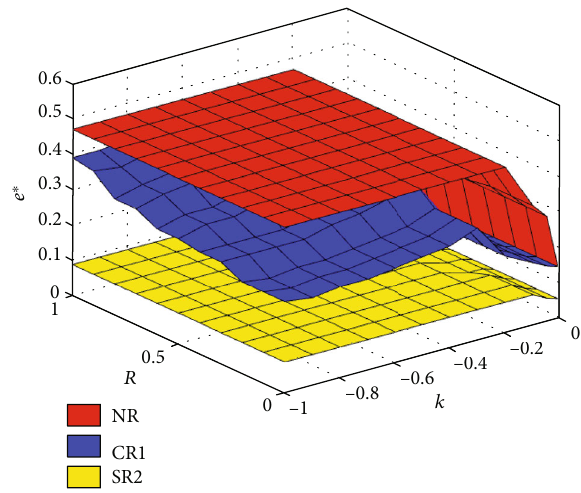
Figure 10: The stability domains of the ETDAS method in space ( k , R , and e ∗ ) for the three cases.